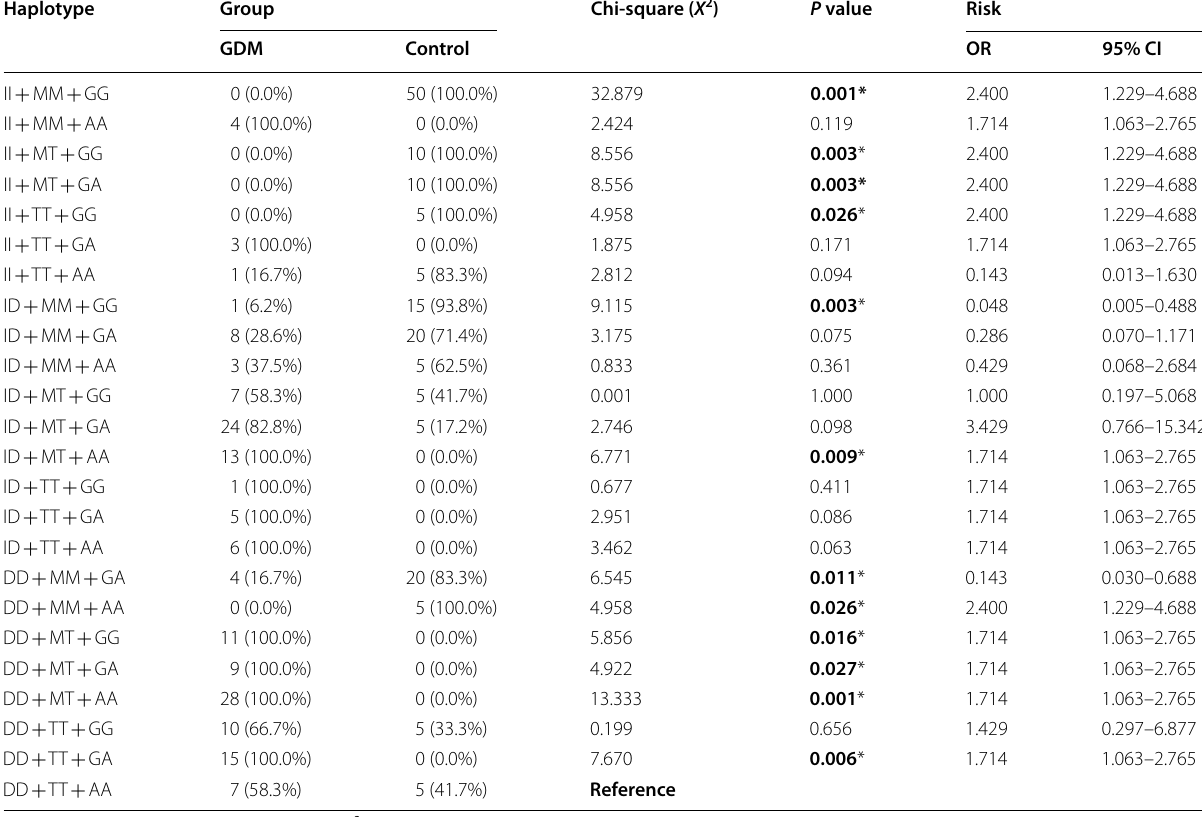
Table 6 Haplotype association of ACE (I/D), AGT (M/T), and ARNT (G/A) between GDM and control